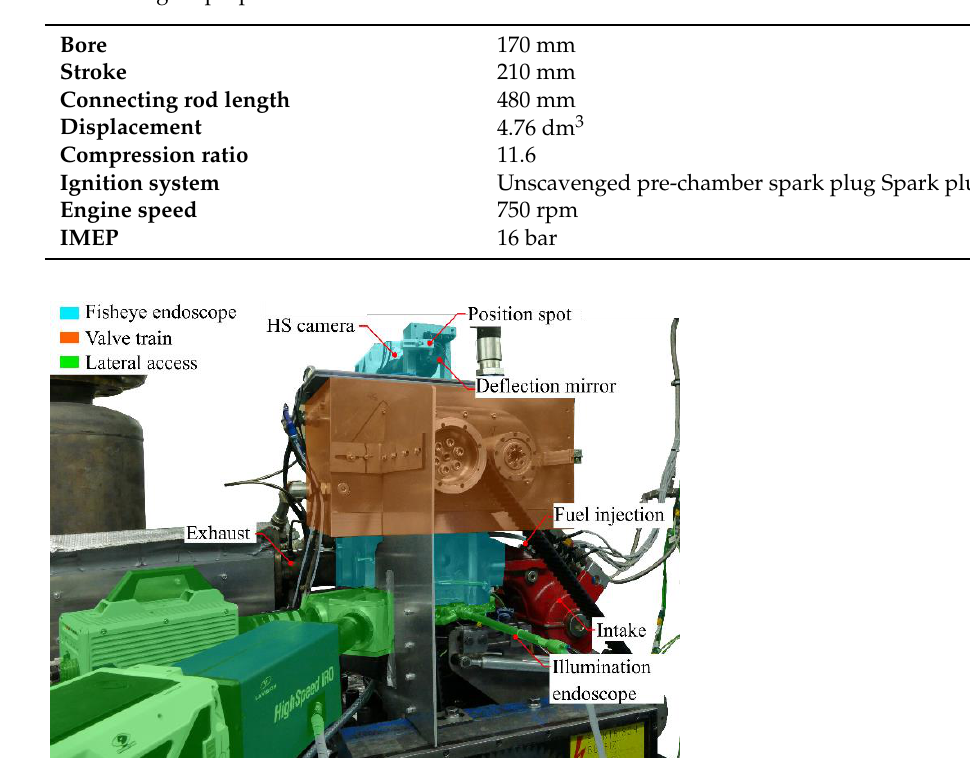
Table 2. Engine properties.